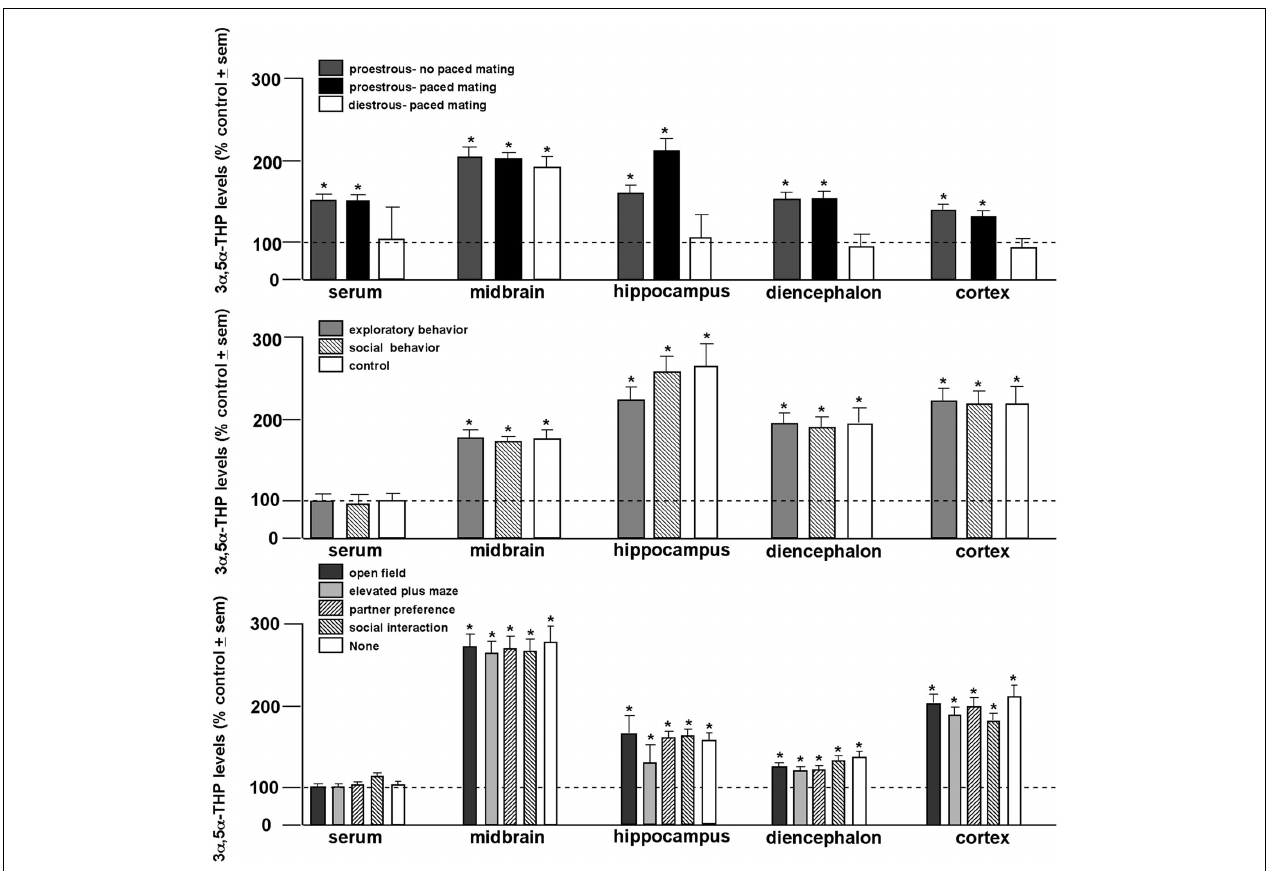
social (partner preference and social interaction) tasks compared to non-mated proestrous rats (middle). Among all tasks, only paced mating enhances 3 α ,5 α -THP levels of proestrous rats compared to non-mated proestrous rats. Line indicates performance of non-mated diestrous (top) or proestrous (middle, bottom) control. ∗ Indicates p <